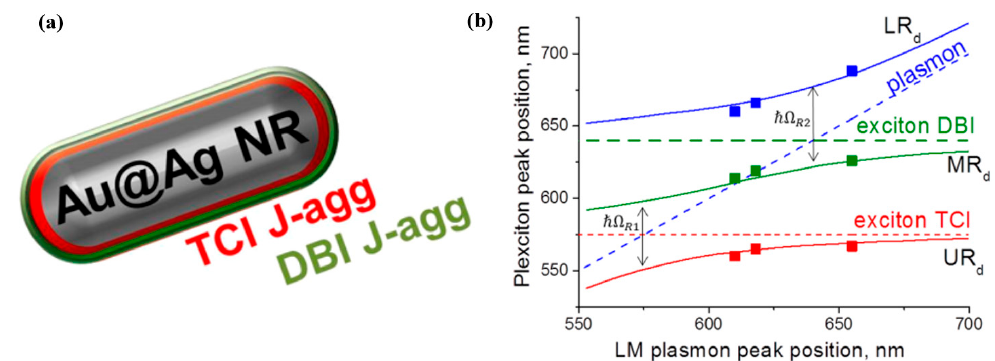
Figure 13. ( a ) Schematic diagram of the single hybrid structure, which is integrated by three different components, such as core–shell Au@Ag nanorods (NRs) and two different dyes. ( b ) Positions of LRd (blue squares), MRd (green squares), and URd (red squares) in the experimental extinction spectra of the hybrid structure of Au@Ag NRs and J-aggregates of TCI and DBI dyes with double Rabi splitting, as a function of the plasmon peak position in the spectra of bare NRs. Adapted with permission from Ref. [92]. Copyright 2019 American Chemical Society.